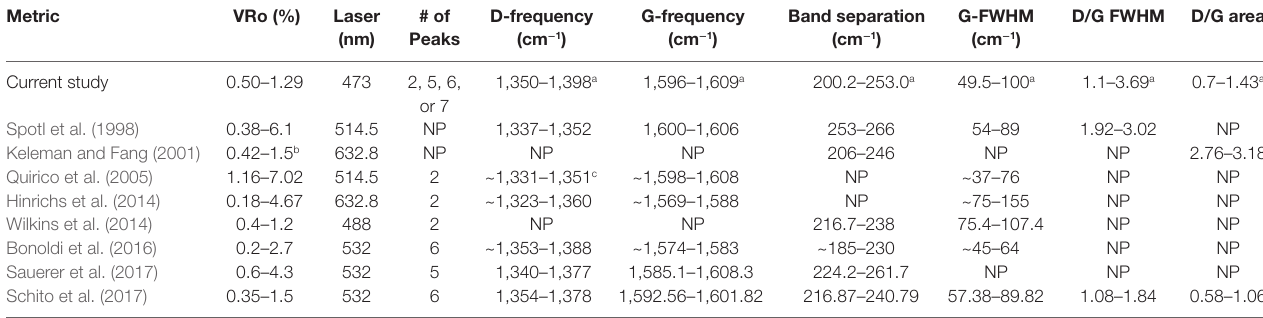
Table 6 | Comparison of Raman spectral metrics calculated in the current study with metrics from the literature. Metric Vro (%) laser